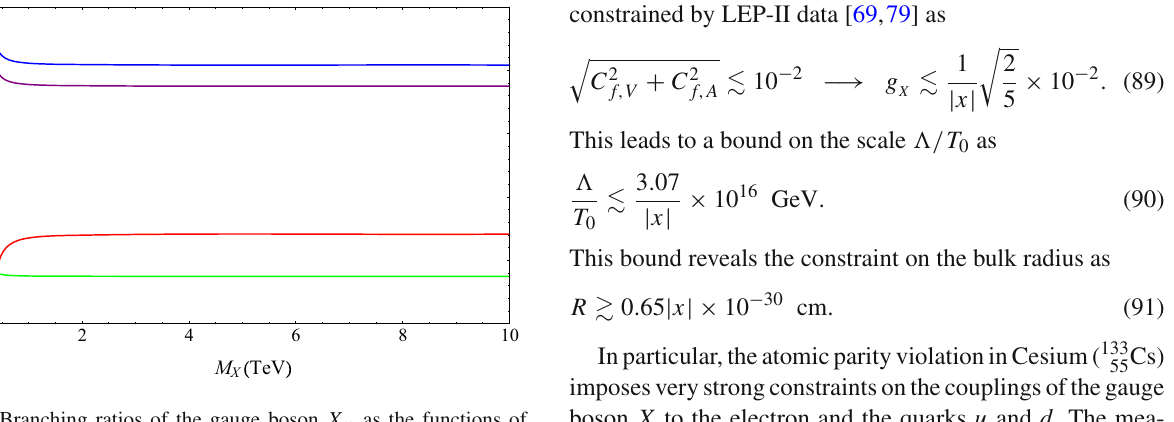
This shows that the decay channels X → l + l − and X → ¯ qq ( q = u , d , s , c , b ) are the dominant ones and thus the decays of the gauge boson X can be accessible via these